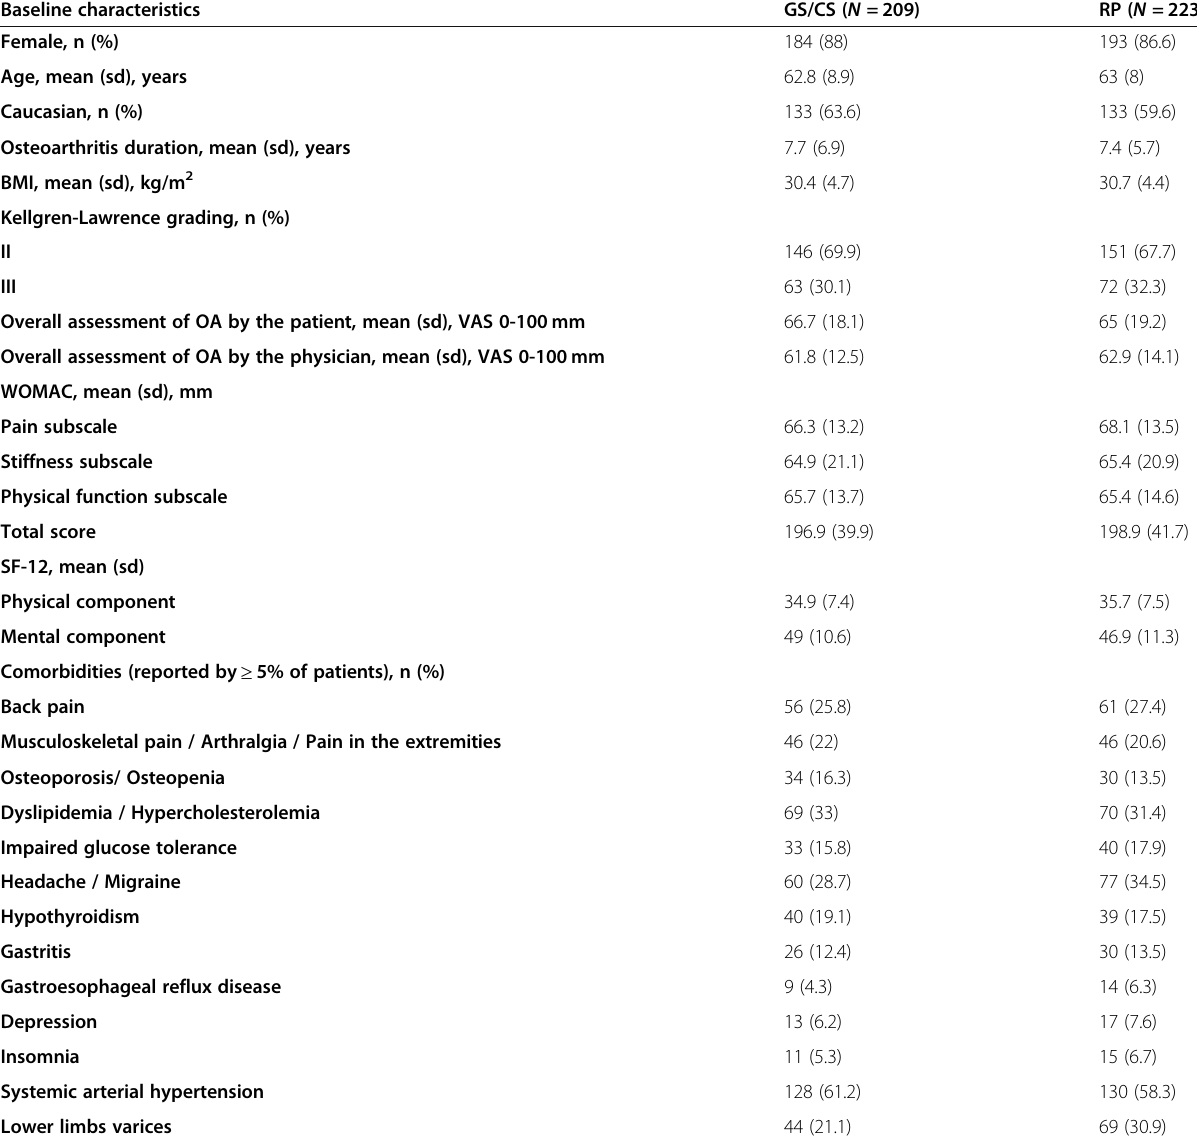
Table 1 Baseline clinical and demographic characteristics in PP